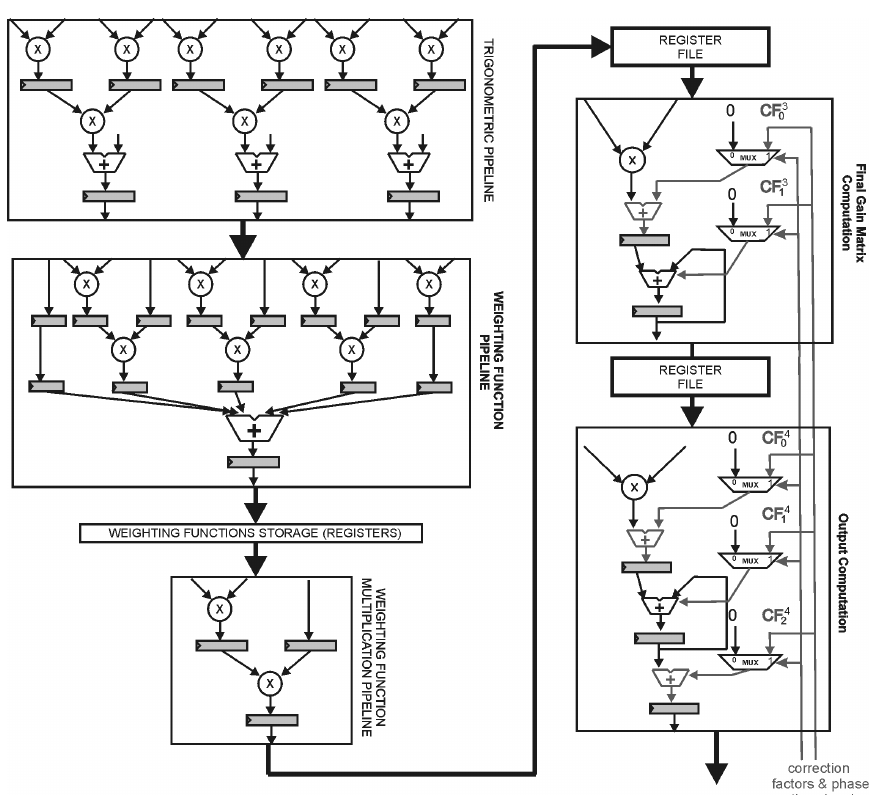
Figure 4. 2-degree of freedom (DOF) robot arm controller hardware